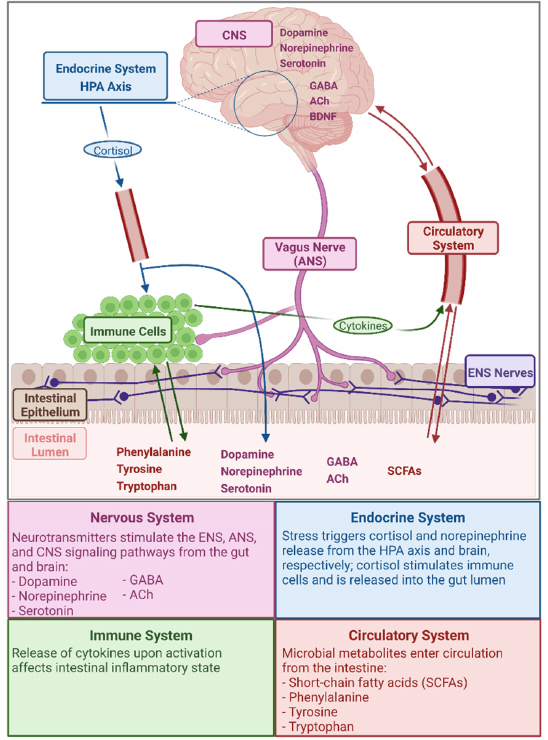
Figure 1. Illustration and brief summary of gut microbiota–gut–brain axis pathways and several com- pounds relevant to this axis. Created with BioRender.com (figure inspired by Cryan and Dinan [33]). Microbial Metabolites Relevant in the